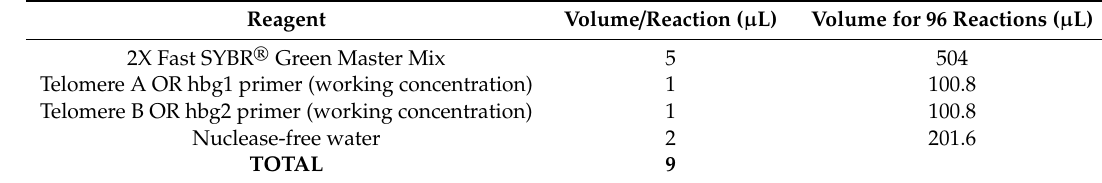
Table 1. Preparation for PCR reactions. Reagents and their volumes per PCR reaction are provided. We also indicate the volumes needed for 96 reactions that include a 5% extra amount to accommodate pipetting errors.